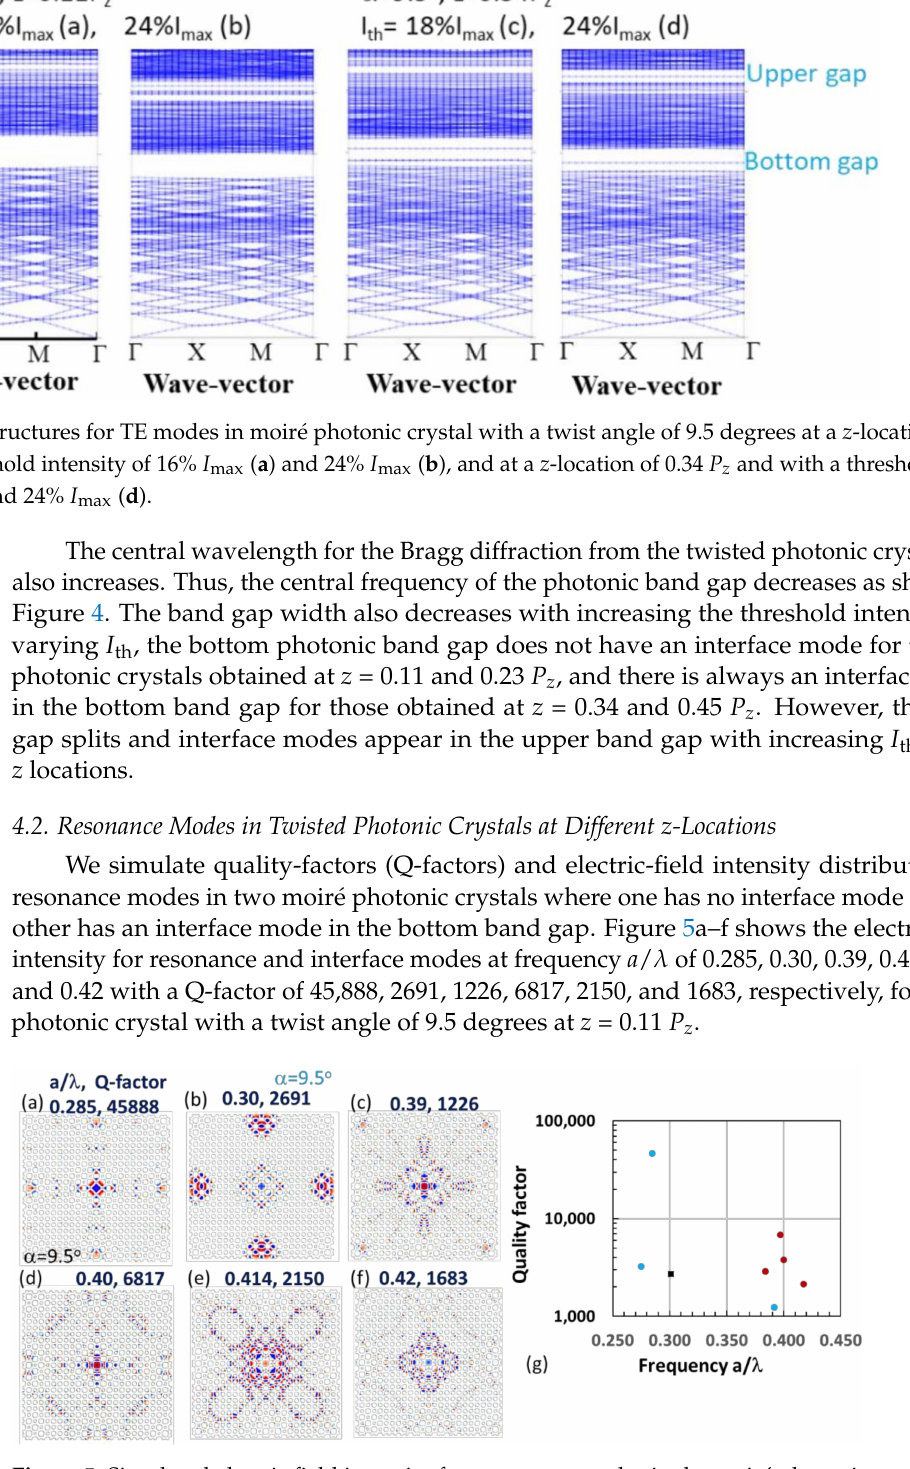
Figure 5. Simulated electric field intensity for resonance modes in the moir é photonic crystal with a twist angle of 9.5 ◦ obtained at z = 0.11 P z and I th = 24% I max . The frequency a/ λ and Q-factor are labelled in each figure ( a – f ). ( g ) Calculated Q-factors at certain frequencies for resonance modes in the moir é photonic crystal with a twist angle of 9.5